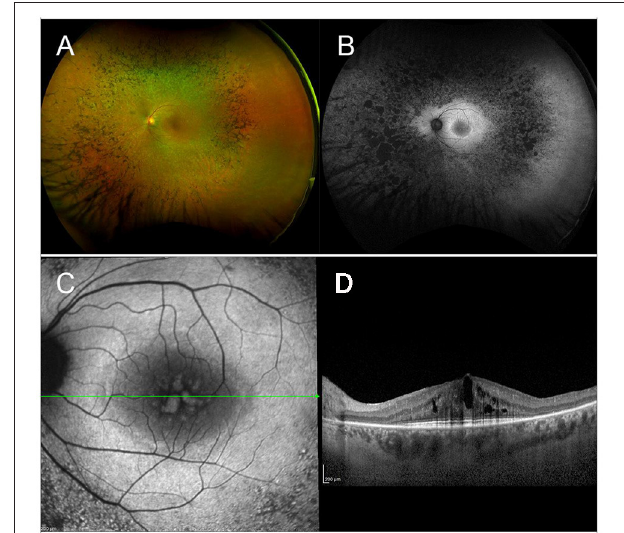
FIGURE 1 | Multimodal imaging in RP. (A) Ultra-wide field retinography displays the typical triad: optic disc pallor, vessel attenuation, and bone spicule pigmentation. (B) Fundus autofluorescence shows the typical perifoveal ring of hyperautofluorescence and multiple hypoautofluorescent regions, corresponding to the pigment deposits, and to the areas of RPE atrophy. (C) Blue fundus autofluorescence shows a petaloid hyperautofluorescent pattern, compatible with a cystoid macular edema. (D) Structural OCT confirms the presence of intraretinal